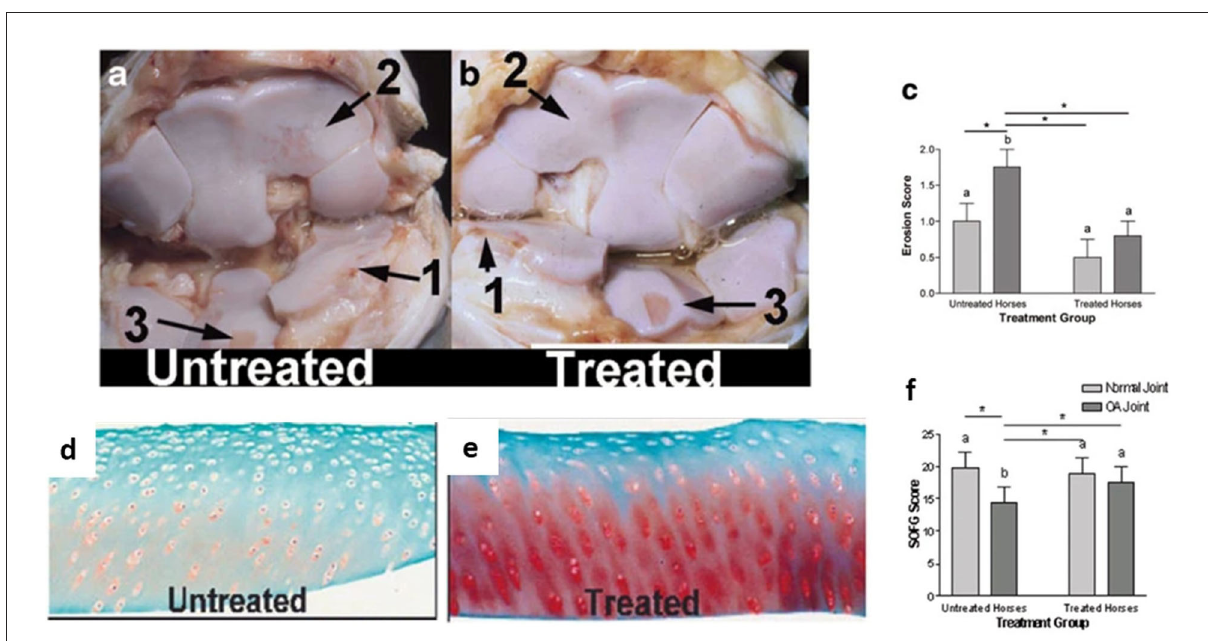
FIGURE3 Effect of osteoarthritis and gene transfer on cartilage erosion. Photographs of the intercarpal joint illustrating extensive full-thickness articular cartilage erosions in OA joints of both untreated (a) and adenoviral vector encoding equine IL-1Ra (Ad-EqIL-1Ra) (b) treated horses. Erosions are evident in the untreated joint especially in areas of the third carpal bone (2) not adjacent to the osteochondral fragment (1). (3) shows the area of aseptic harvest of cartilage from the intermediate carpal bone. (c) presents cartilage erosion scores by treatment group. Sections of articular cartilage stained with SOFG demonstrating little or no stain uptake in the OA joint of an untreated horse (d) vs. moderate stain uptake from an OA joint with Ad-EqIL-1ra treatment (e) . Plot of SOFG scores by treatment group (f) . Different letters associated with bars indicate a statistical difference ( P < 0.05) between bars. Lines with an asterisk (*) linking treatment groups indicate a statistical difference between treatment groups. Reproduced with permission from Frisbie et al.